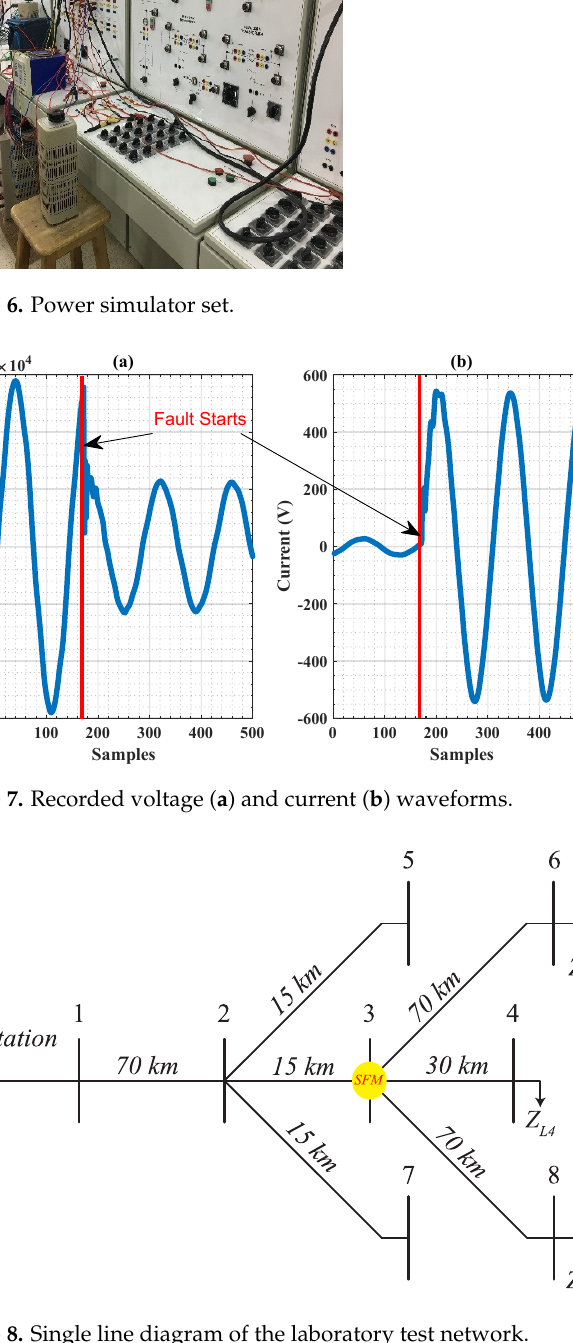
Figure 6. Power simulator set. Table 4. Laboratory and simulation result of single-phase to ground fault.